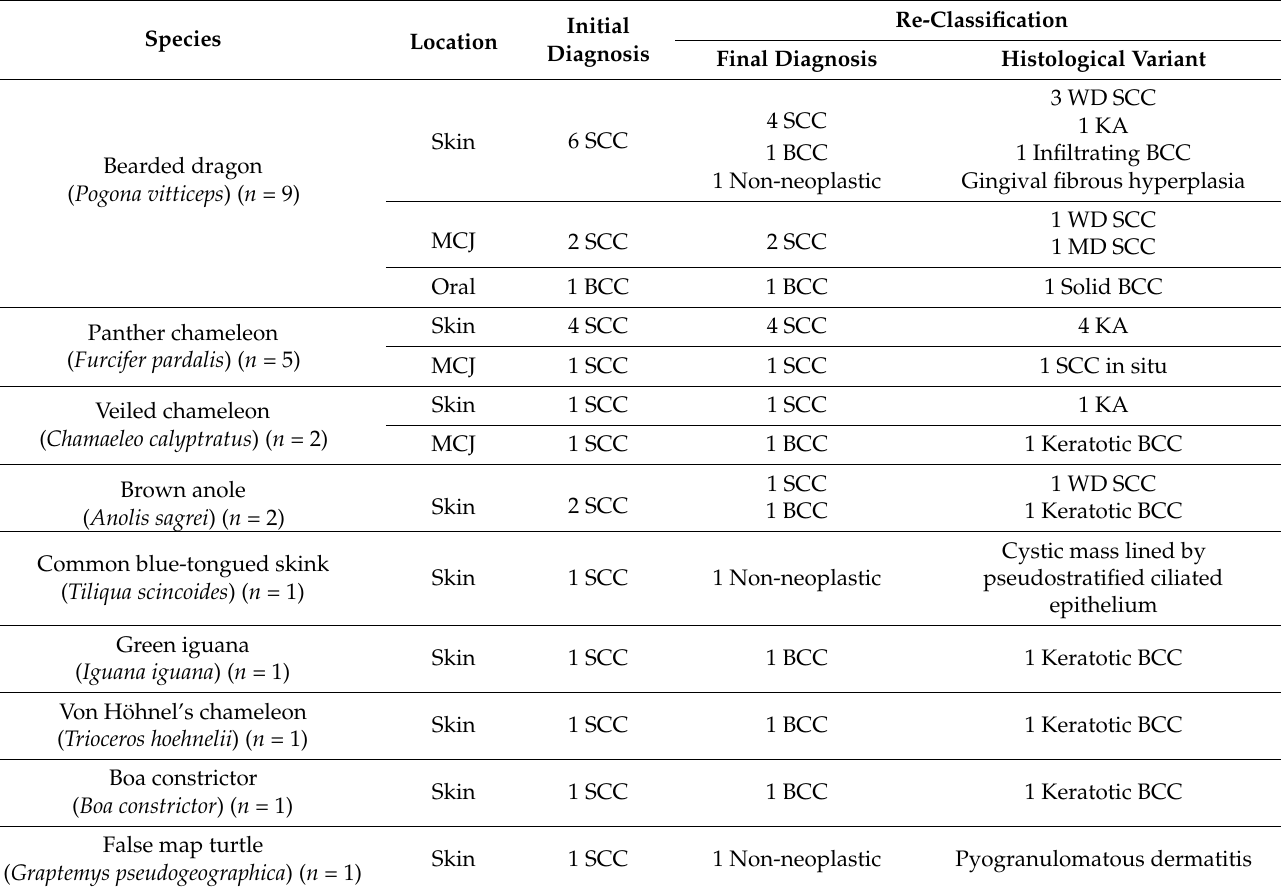
Table 1. Anatomic location and number of tumors from 35 reptile patients that were initially diag- nosed as squamous cell carcinomas (SCCs) or basal cell carcinomas (BCCs) and re-classified into histological variants following retrospective histological and immunohistochemical